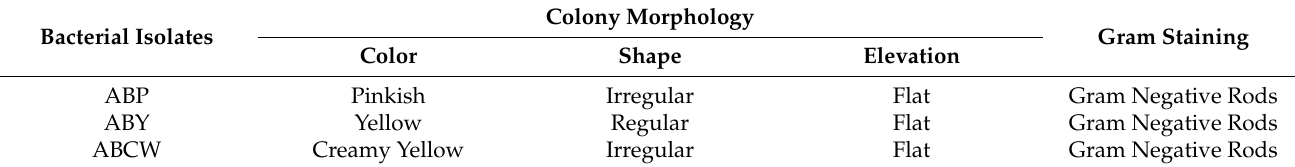
Table 3. Colony Morphology and Gram Staining of Bacterial Isolates.